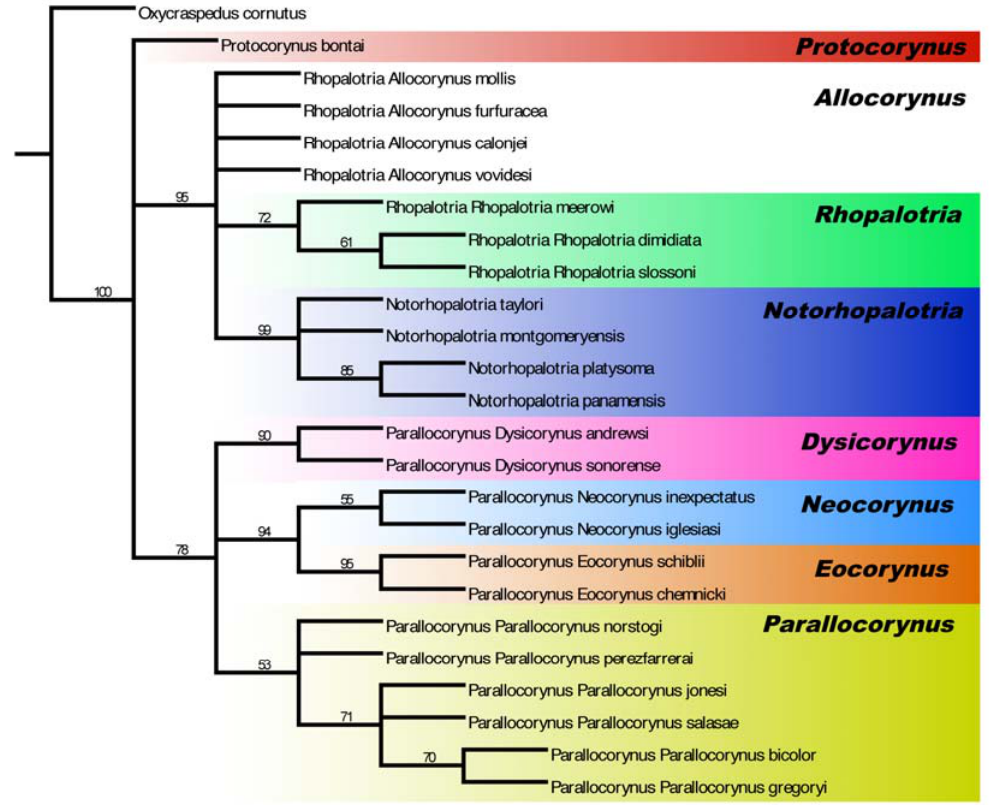
Figure 2. Phylogenetic tree for the Allocorynina based on maximum parsimony analysis of the matrix of morphological, behavioral, and host characters in Appendix B; Oxycraspedus cornutus is used as the outgroup; numbers are bootstrap values.